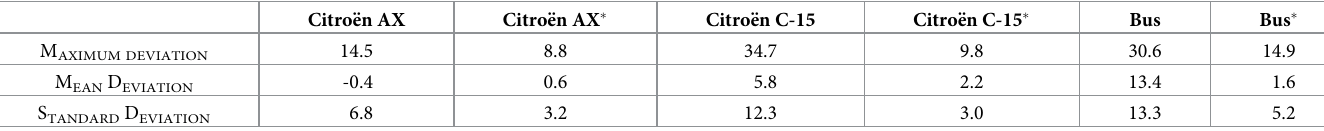
Table 12. Statistical analysis. Vehicles which include � correspond to sectioned